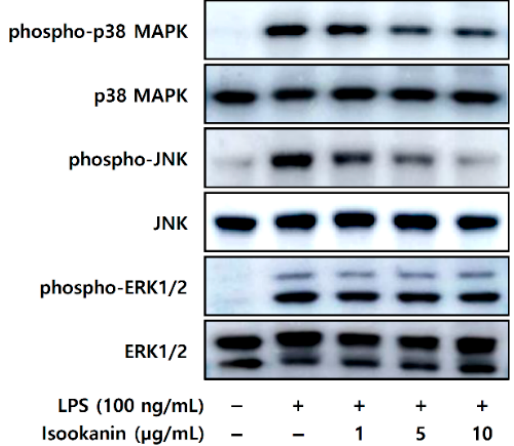
Figure 6. Effects of isookanin on the phosphorylation of mitogen-activated protein kinases (MAPKs) in LPS-induced RAW 264.7 cells. The RAW 264.7 cells were cultured for 24 h, and then treated with LPS (200 ng/mL) in the presence or absence of isookanin. Cell lysates were prepared at 20 min, and then subjected to Western blot analysis. The bands for phospho-ERK1/2, phospho-p38 MAPK, and phospho-JNK were detected and normalized to their total forms of MAPKs.